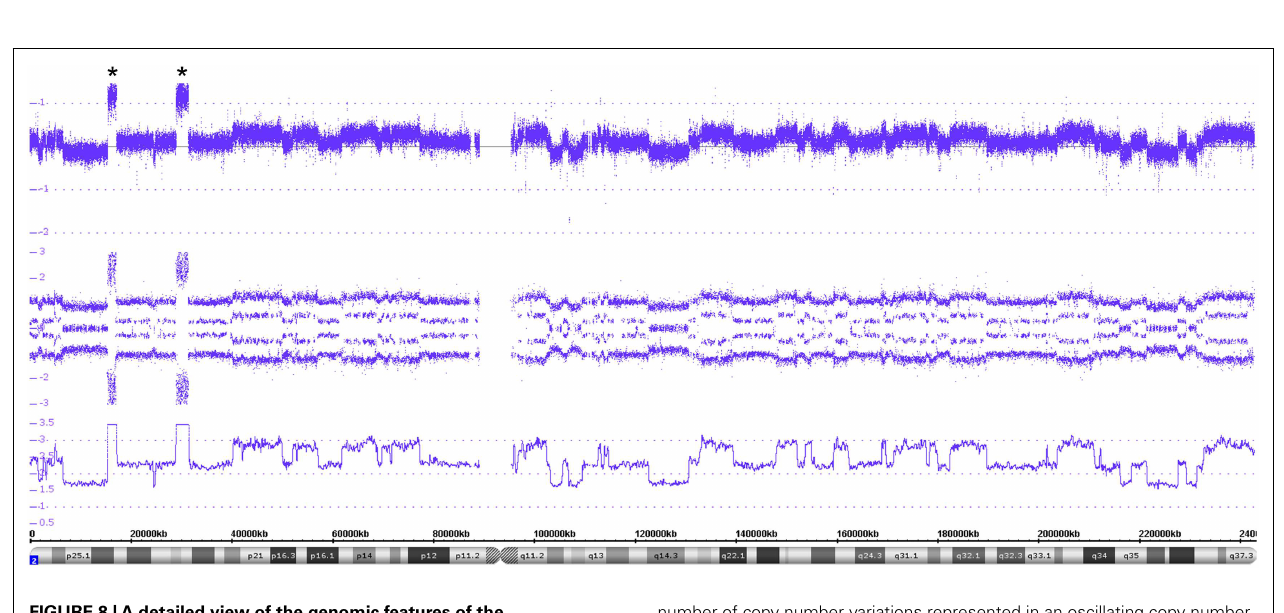
FIGURE 8 |A detailed view of the genomic features of the chromothripsis case described in Figure 7 .The chromothripsis with 60 breakpoints lying in both chromosomal arms (chromosome 2) lead to a large